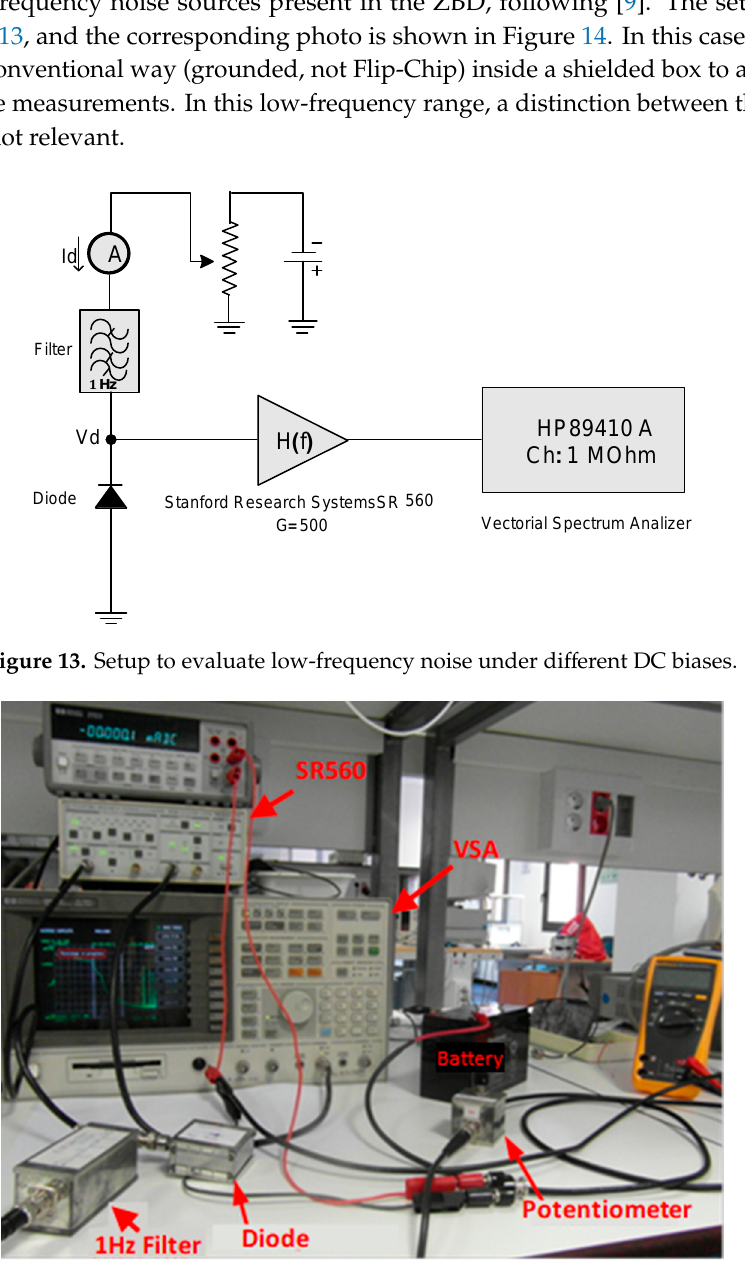
Figure 14. Photo of the measurement setup for low-frequency noise, corresponding to the diagram in Figure